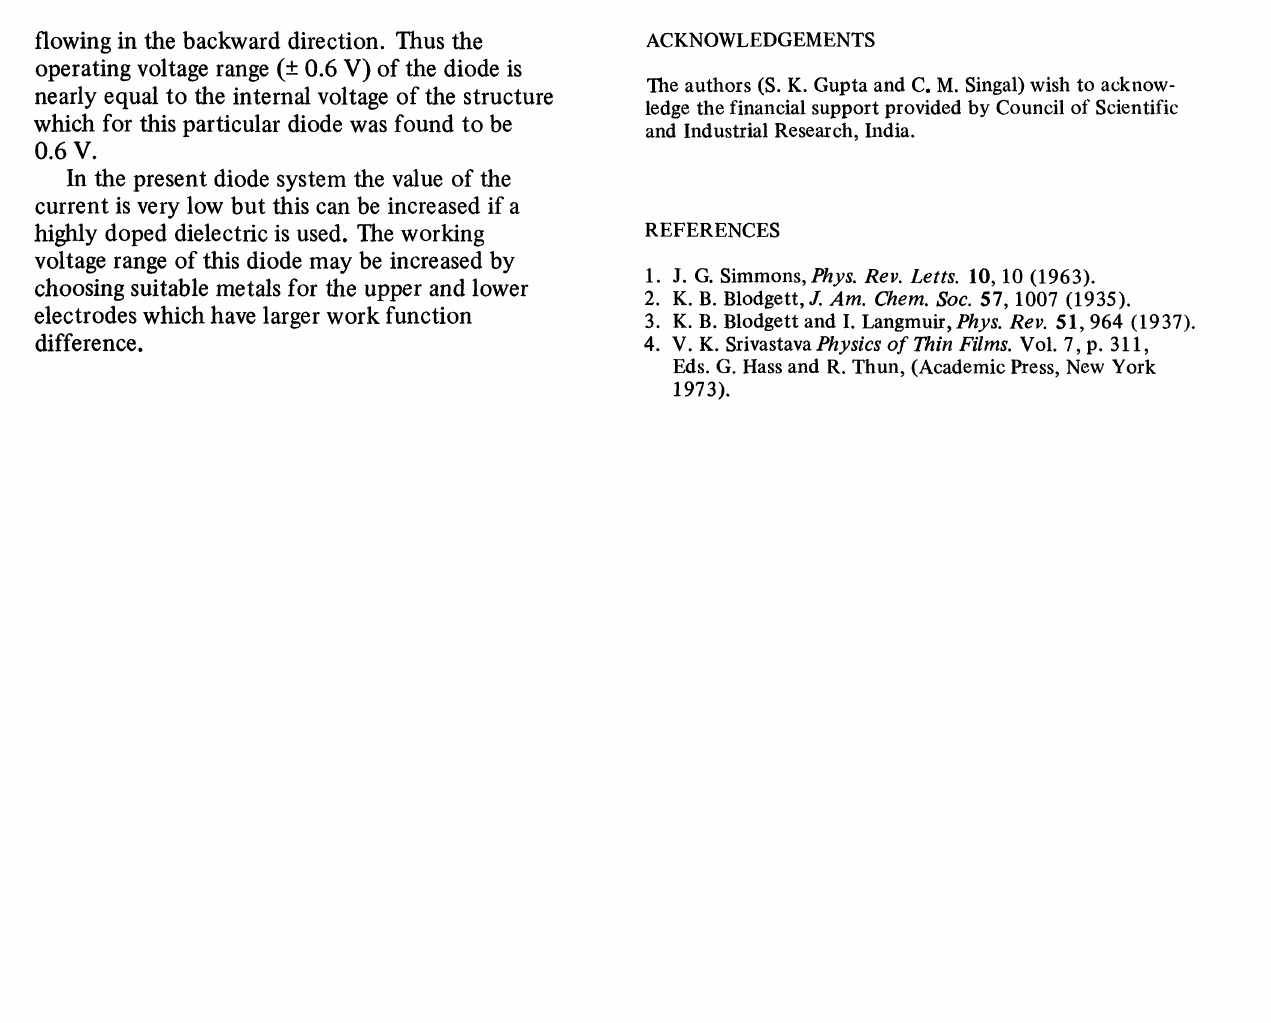
FIGURE Diode characteristics of an aluminium-four layer barium stearate-tin